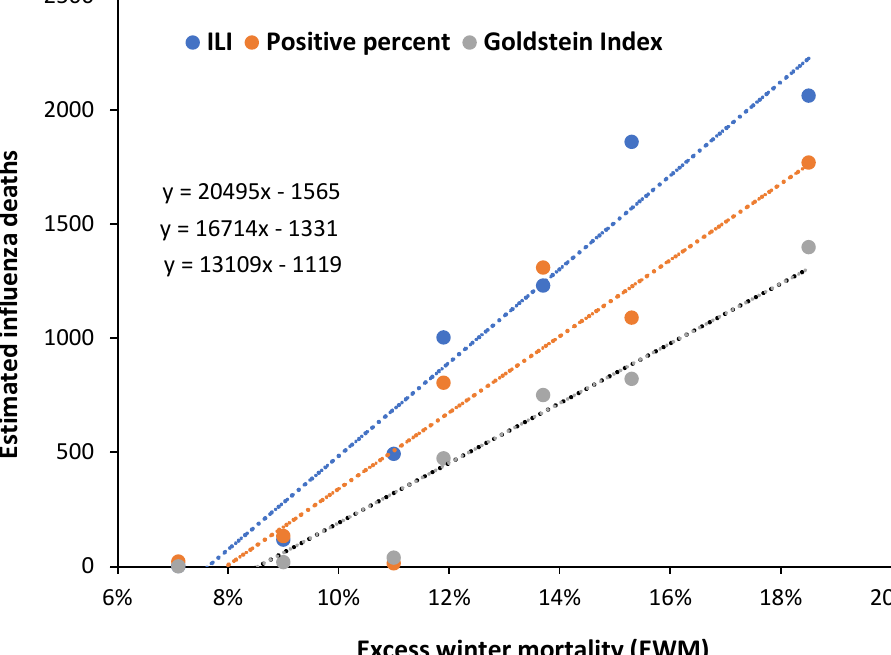
Figure 5. Three different methods for estimating influenza deaths in Denmark, 2010/11 to 2016/17. Influenza deaths are from the study of Nielson et al. [52]. FluMOMO data were adjusted for excess deaths arising from periods of very cold weather. The Goldstein Index method is considered the most reliable method. R-squared for the 3-methods ranges from 0.851 (Positive percent), 0.9178 (Goldstein) to 0.9482 (Influenza-like-illness).